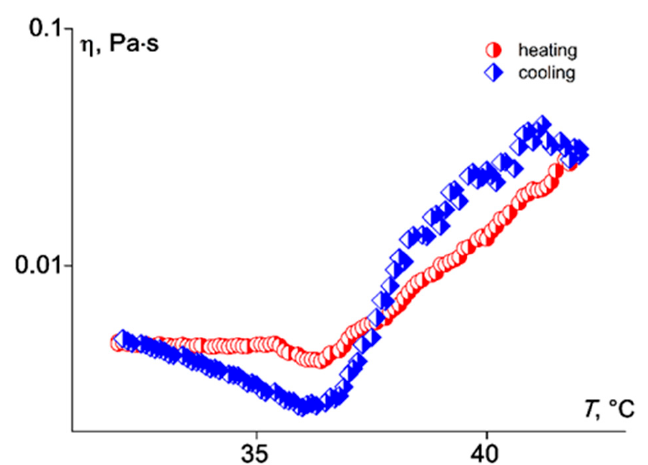
Figure 6. The temperature dependence of the dynamic viscosity η during the temperature sweep experiments in the heating-cooling cycle. The concentration is 15 wt.%; the shear rate γ = 100 s − 1 . The change in the particle sizes a ff ected the solution viscosity. The measurement of the dynamic viscosity in the steady state regime allowed the leveling of the e ff ect of individual cross-linked particles on the gel flow that could interfere with the gelation process examination. The CL-PiPrOx exhibited a temperature-induced sol-gel transition in water; the viscosity η value rose approximately 25 times upon heating (Figure 7).